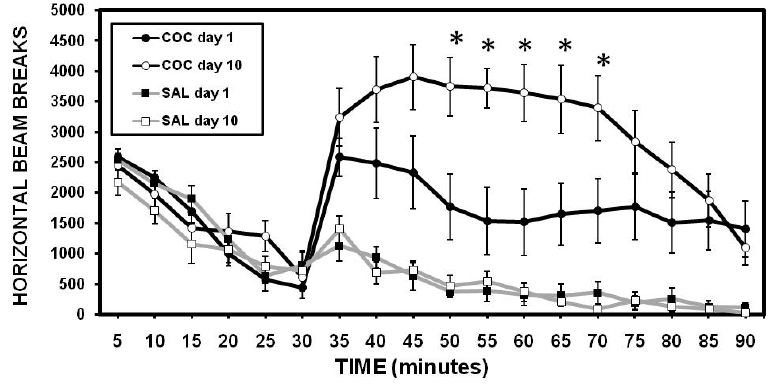
Figure 1. Mean ± SEM number of horizontal beam breaks in 5 min bins on day 1 and day 10 during 90 min activity trials. Saline (SAL n = 8) or 15 mg/kg cocaine (COC n = 9) injection were given IP at 30 min. * Indicates a significant difference between COC day 1 and COC day 10 ( p <